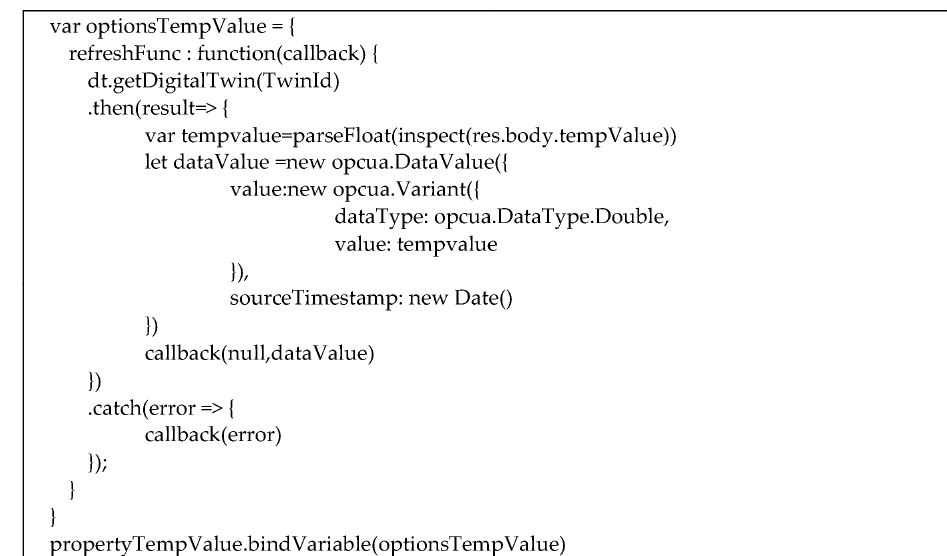
Figure 16. Automatic update of the tempValue property.